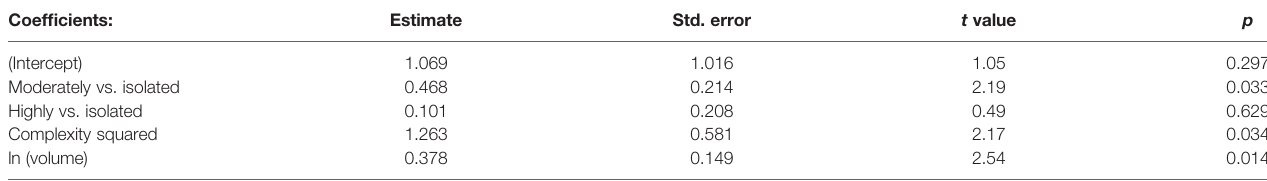
TABLE 4 | Simpli fi ed generalized linear model (ANCOVA) for total abundance of fauna in the rhodoliths (Isla del Coco, Costa Rica). Coef fi cients: